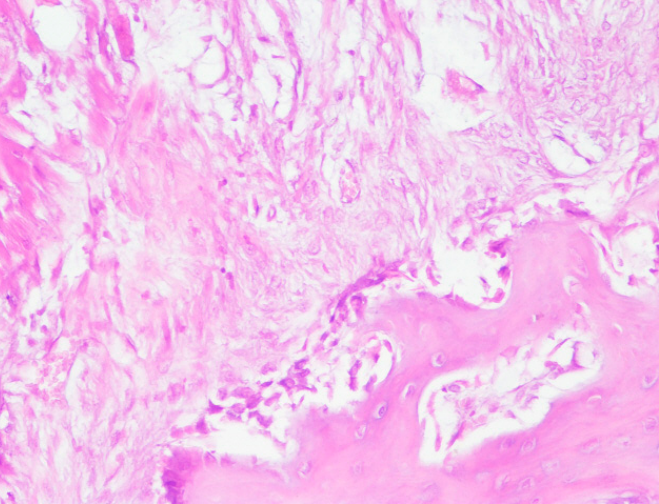
Figure 7. Reactive osteogenesis near the titanium implant.